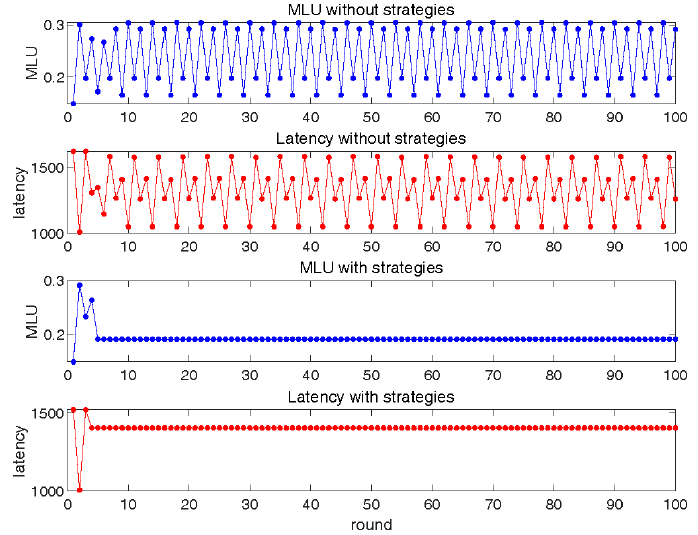
Figure 8. Interaction between basic SRC and LLS.